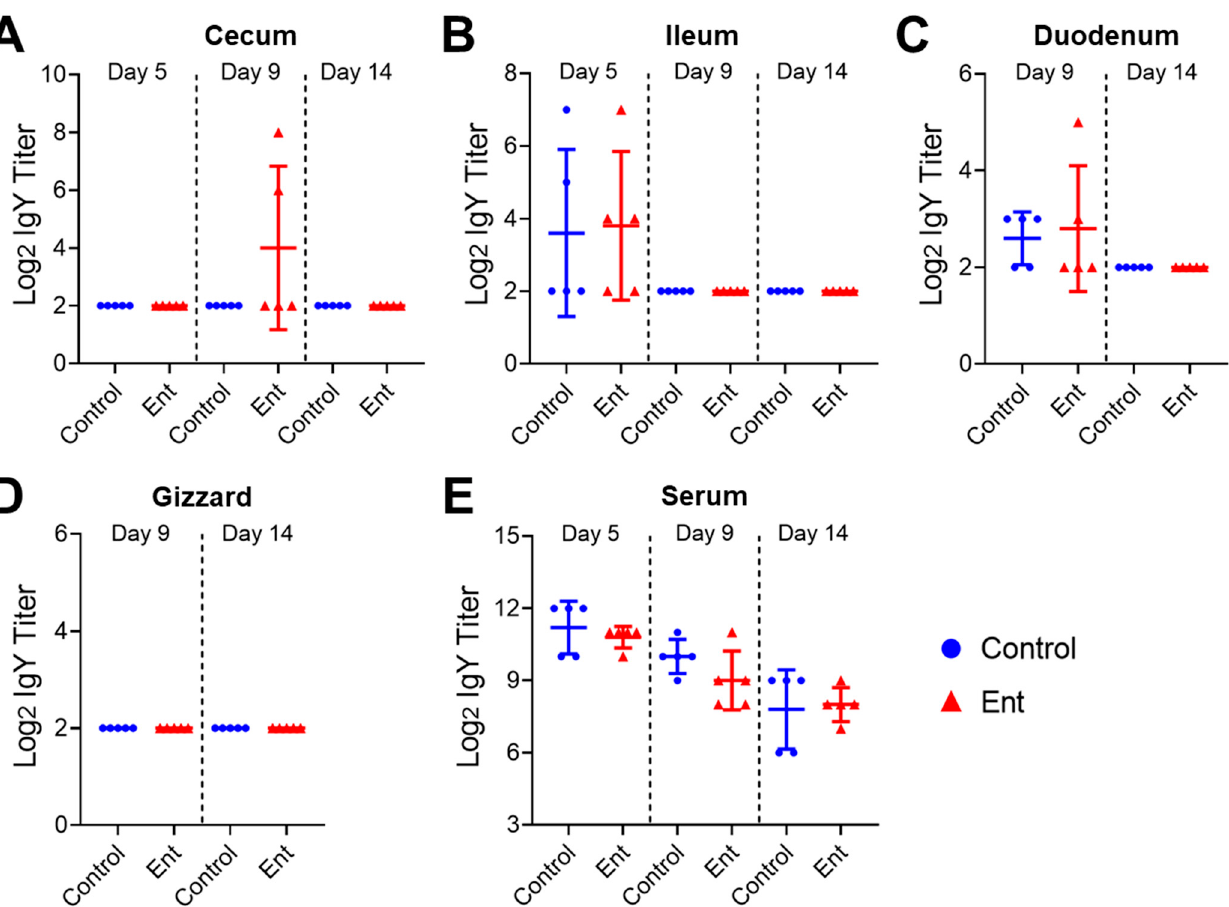
Figure 3. The levels of the specific egg yolk IgY in different GI contents and serum. ELISA analysis was performed to determine the titers of the Ent conjugate-specific IgY in the ( A ) cecum, ( B ) ileum, ( C ) duodenum, ( D ) gizzard, and ( E ) serum collected from individual chickens fed with control or Ent feeds at different time points. Each dot represents duplicate measurements of a specific sample. Each bar represents mean ± SD within each group.